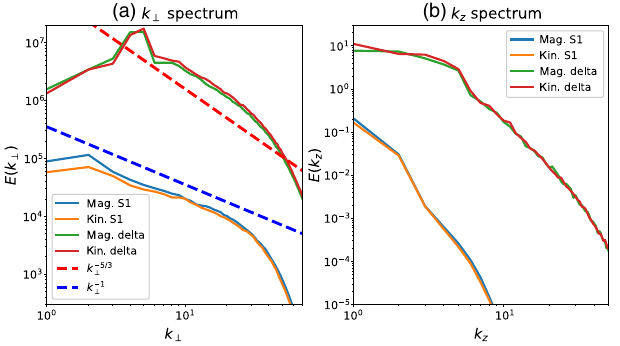
FIG. 4. (a) The k ⊥ spectrum excluding the k z ¼ 0 mode. A delta-correlated-in-time forcing is used to produce a data cube with M A ¼ 0 . 24 (labeled as “ delta ” ), and it is compared with the OU-process forced S1 simulation. The delta-correlated forcing produces a spectrum close to k − 5 = 3 ⊥ , while the S1 simulation has a spectrum k − 1 ⊥ . (b) Comparison of the k z spectrum. The OU forcing produces a very weak energy cascade to higher k z modes, while the delta-correlated forcing produces a stronger cascade.